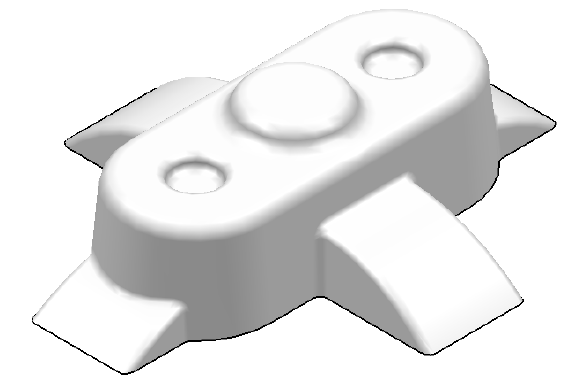
Figure 1. Plastic part virtual model P .